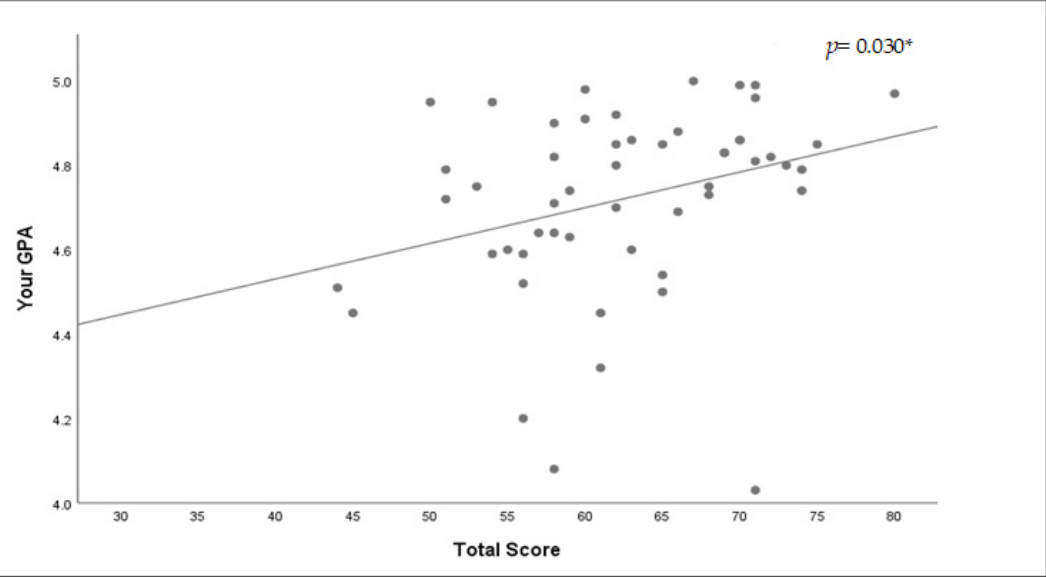
Figure 4. Correlation between GPA and system thinking score with correlation coefficient and p -value. Note. p -values < 0.05 were considered significant. * Spearman’s correlation coefficient = 0.27, p = 0.03